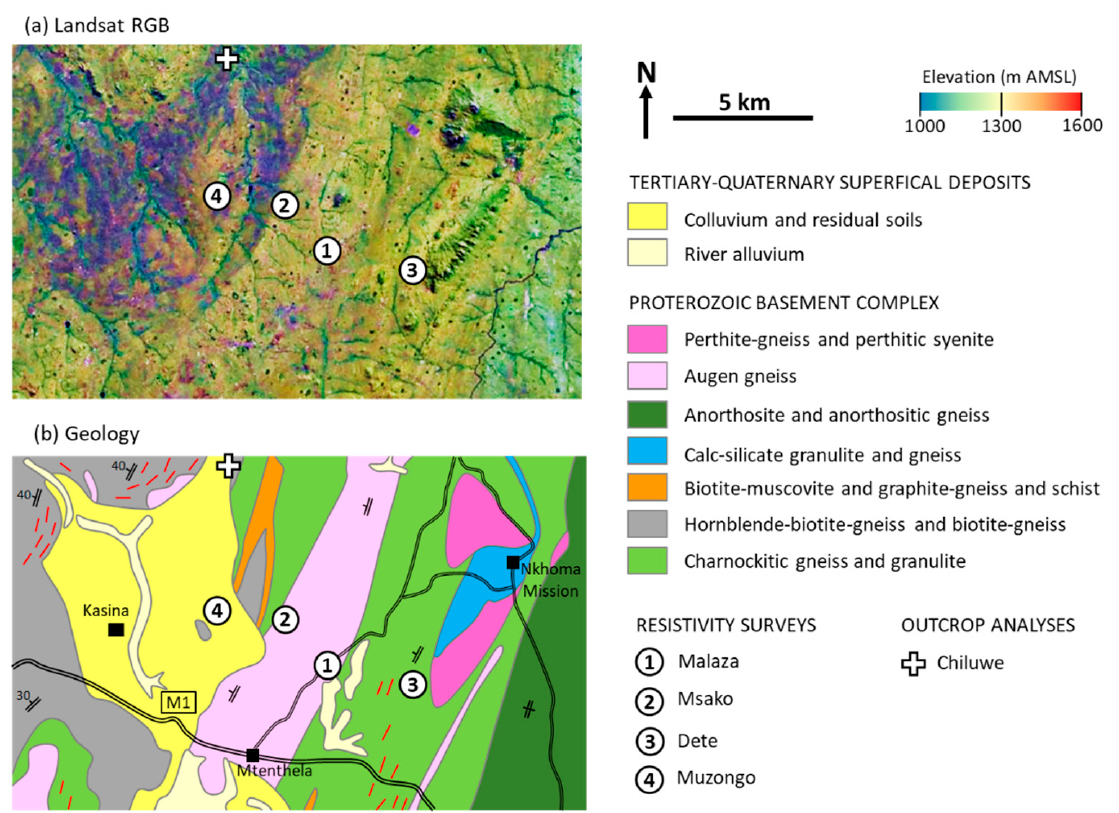
Figure 2. Location of resistivity survey demonstration area shown relative to ( a ) Landsat image [72] and ( b ) the geological setting (digitized, adapted and reinterpreted from Hughes and Matumbi [66]). Landsat imagery courtesy of NASA Goddard Space Flight Center and US Geological Survey.